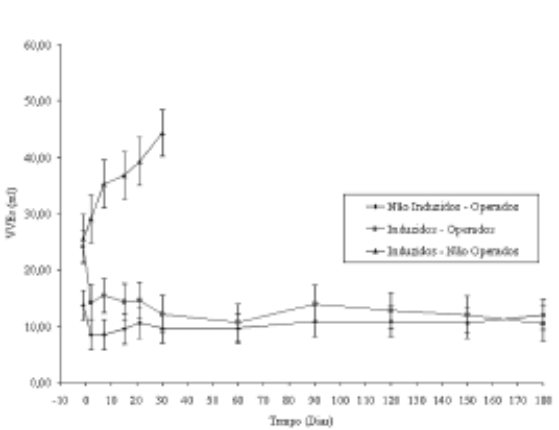
Fig. 4 – Volume do ventrículo esquerdo em diástole (VVEd – ml), ao longo do tempo, de cães hígidos (n=5) ou com cardiomiopatia dilatada induzida pela doxorrubicina (n=4), submetidos à plicatura da parede livre do ventrículo esquerdo e cães induzidos não operados (n=2)